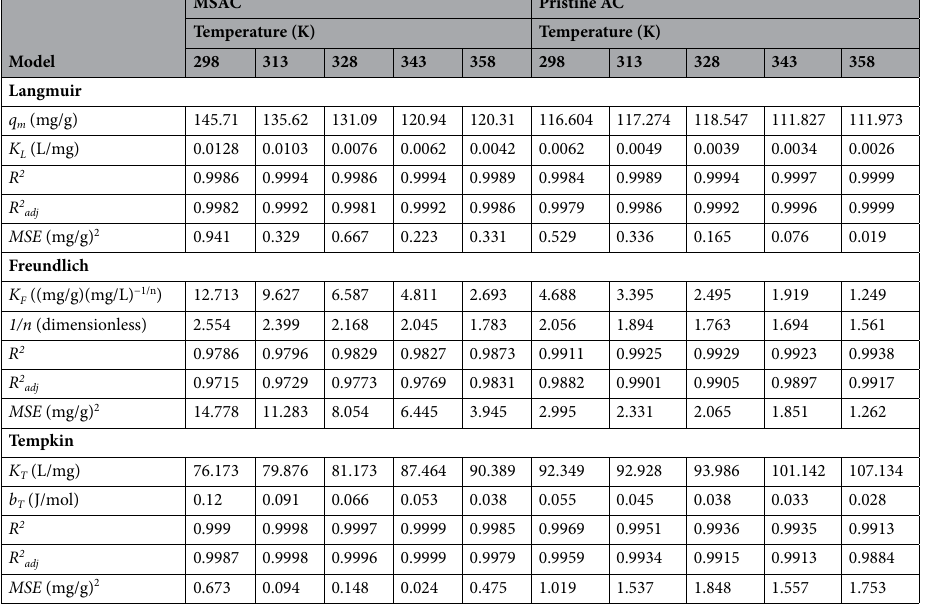
Table 2. Equilibrium adsorption parameters for phenol removal by MSAC and pristine AC.